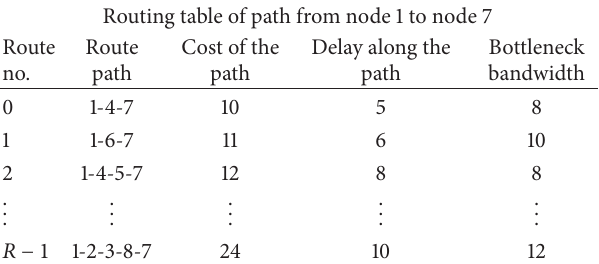
Table 1: An example of routing table for OD pair (1, 7) in Figure 1. Routing table of path from node 1 to node 7